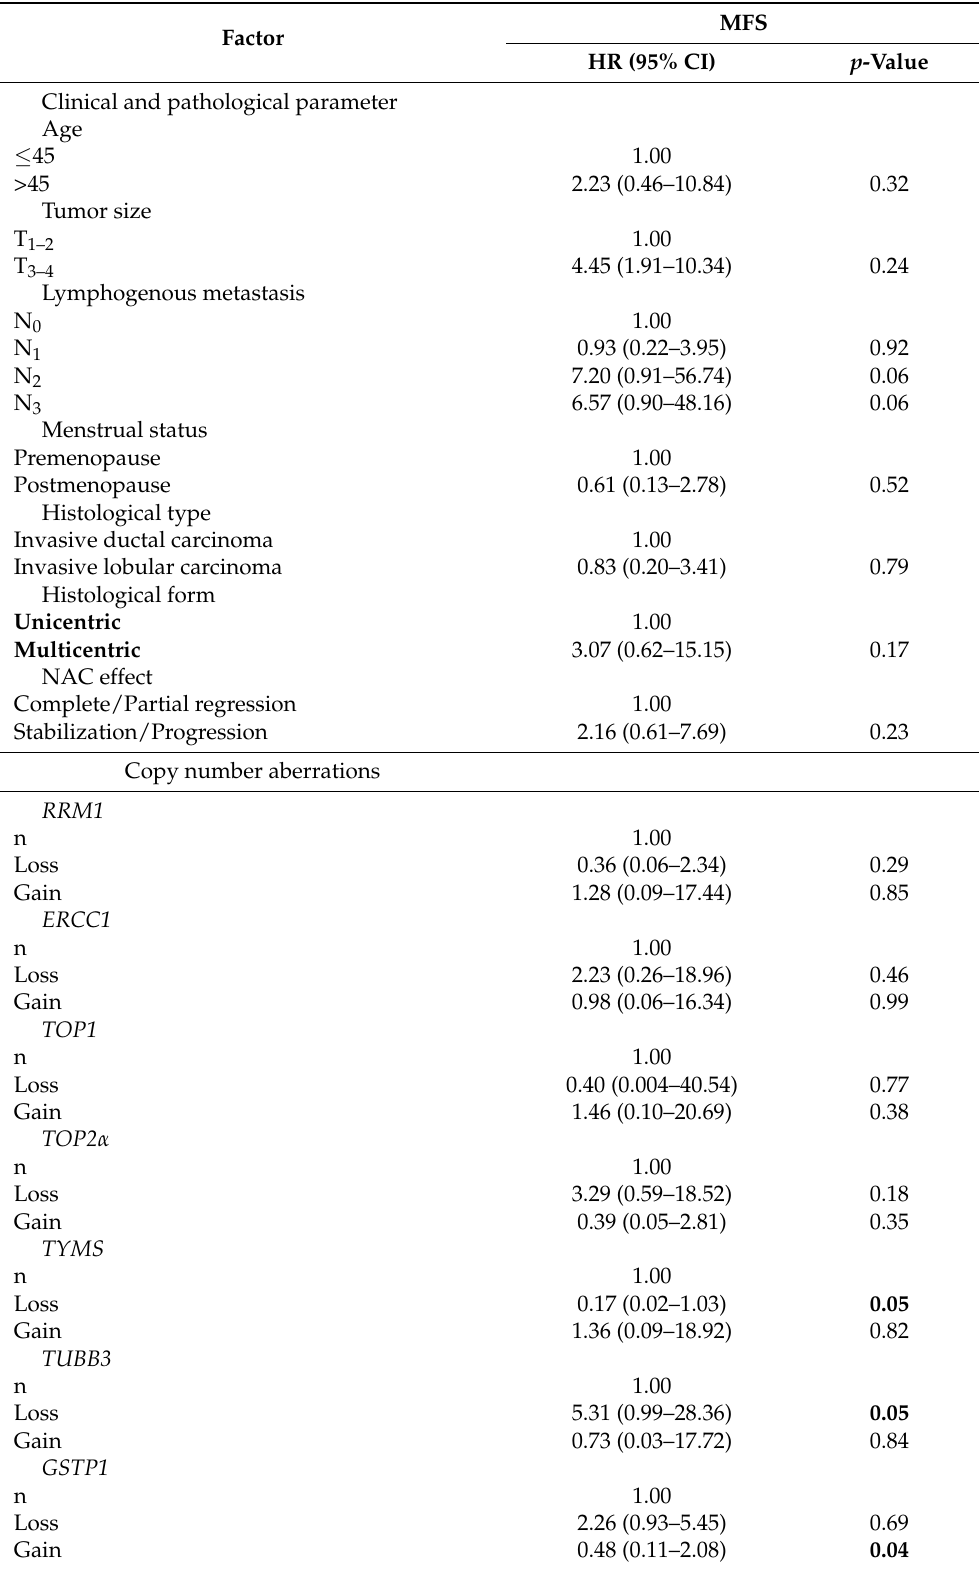
Multivariate Cox regression analysis for metastasis-free survival of patients with breast